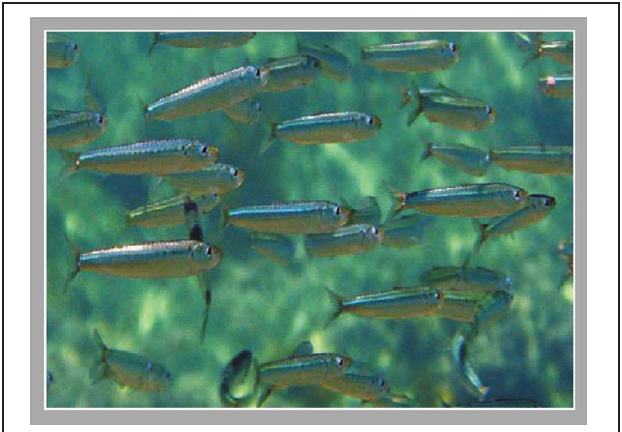
FIGURE 10 | Example of 3D translational motion in the natural environment. A school of fish translating horizontally respect to the observer who is advancing under water toward the